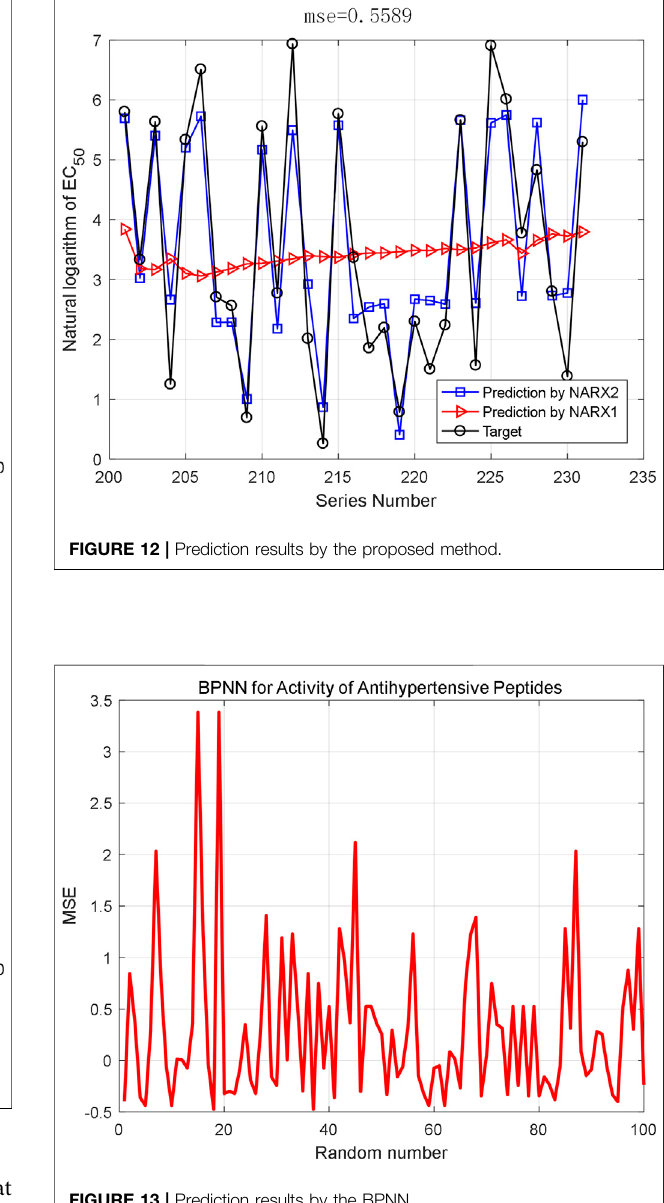
FIGURE 13 | Prediction results by the